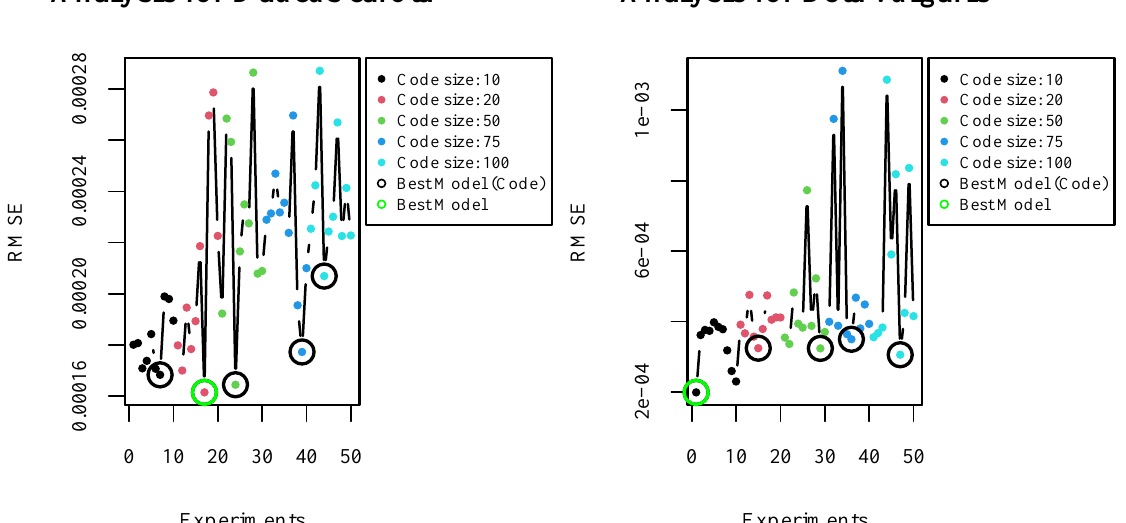
Figure 4. Analysis of the code size for cAE for both data sets. The model with lowest MSE is visualized with a green circle. The best model for each code size is shown in a black circle. The influence of the additional parameters can be seen in the high variation of the loss for larger code